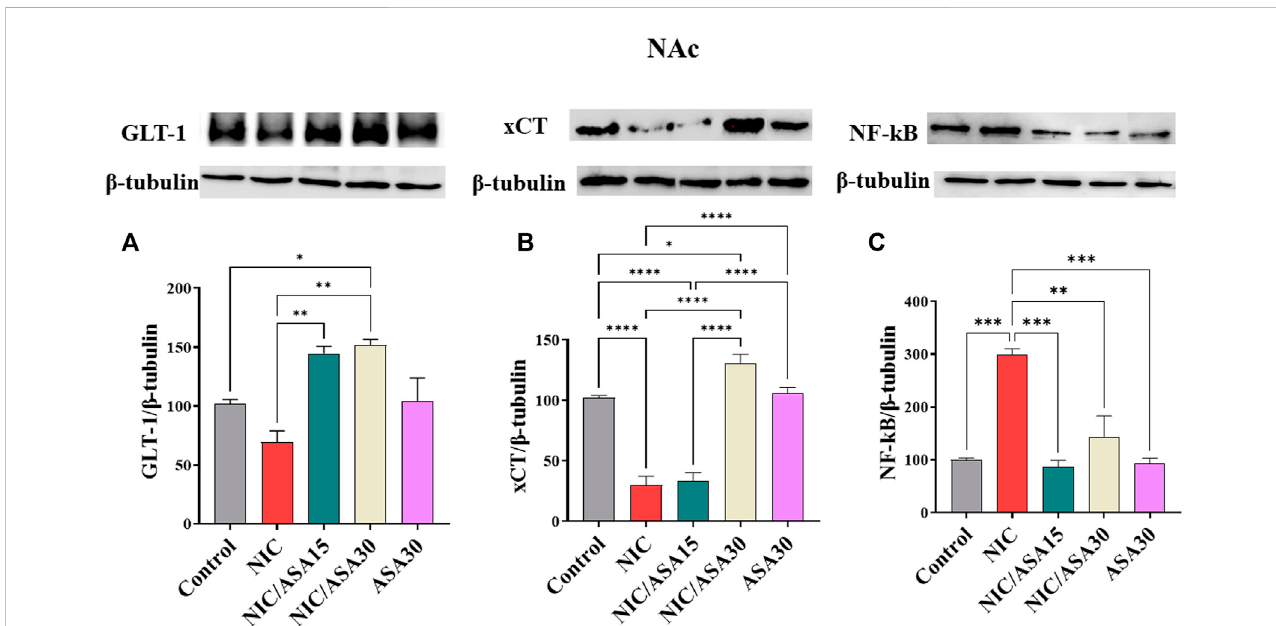
FIGURE 7 GlutamatetransporterslevelinNAcbrainregionsaftertreatments(dataexpressedasmean±SEM). (A) GLT-1; (B) xCT; (C) NF κ B(* p < .05,** p < .01,*** p < .001; n = 5 for each